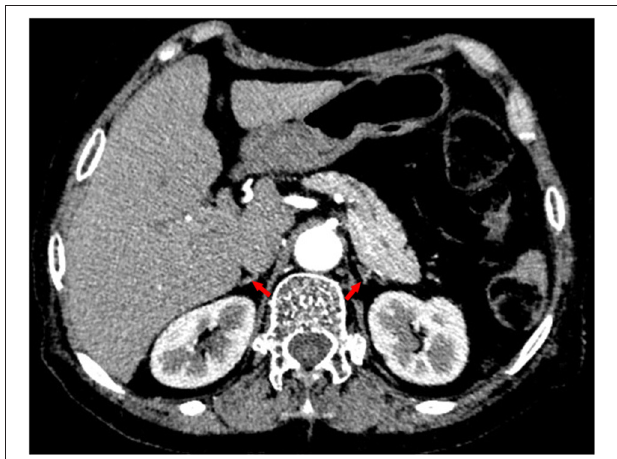
FIGURE 4 | Contrast-enhanced computed tomography revealing atrophic bilateral adrenal glands (red